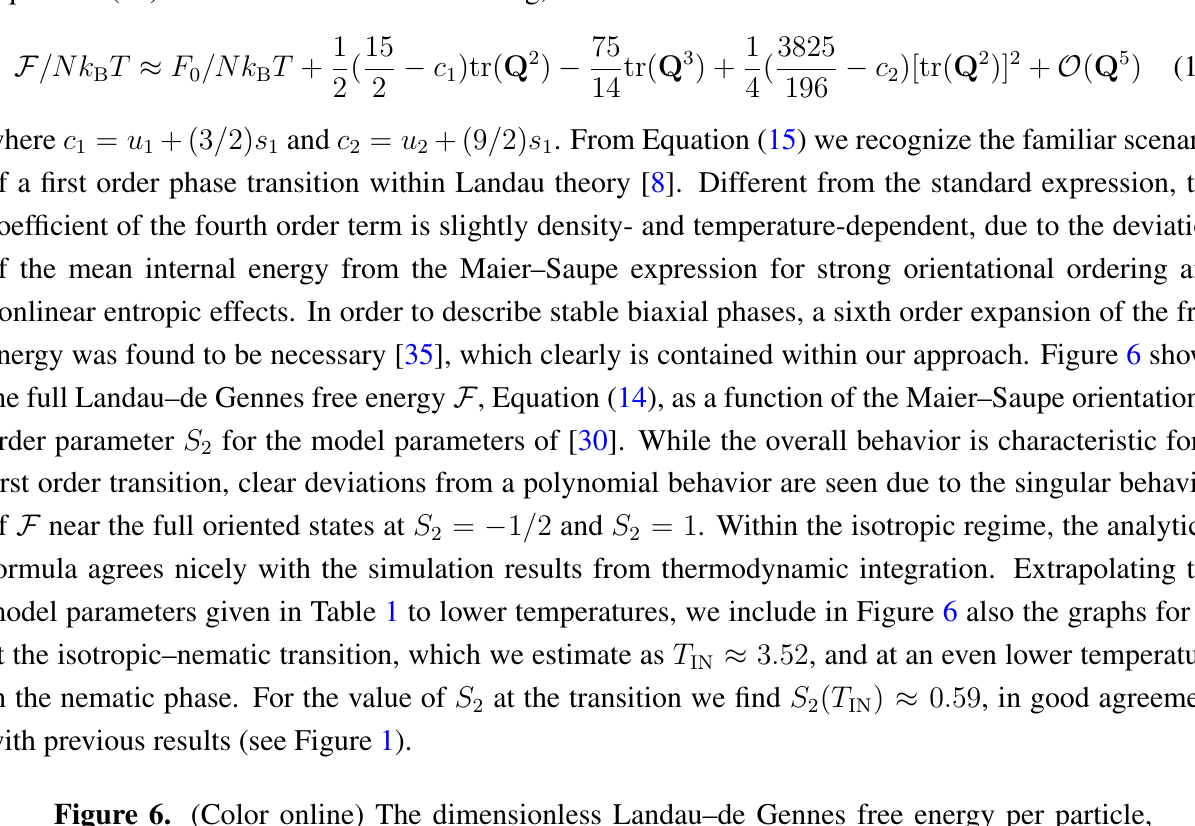
Figure 6. (Color online) The dimensionless Landau–de Gennes free energy per particle, F /Nk T from Equation (14), as a function of the Maier–Saupe orientational order B parameter S , for the Gay–Berne model of [30]. Temperature decreases from top to bottom 2 as T ∗ = 5 . 0 , 4 . 0 , 3 . 52 , 3 . 3 . Symbols denote the result of Monte-Carlo simulation in the generalized canonical ensemble in the isotropic